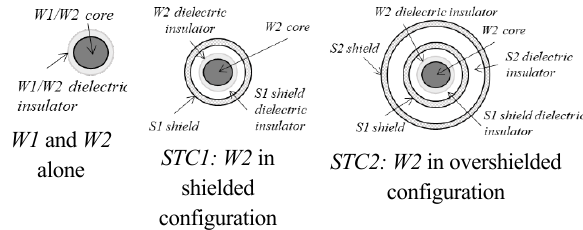
FIGURE 17. Geometrical cross-sections of W1 / W2, STC1 and STC2